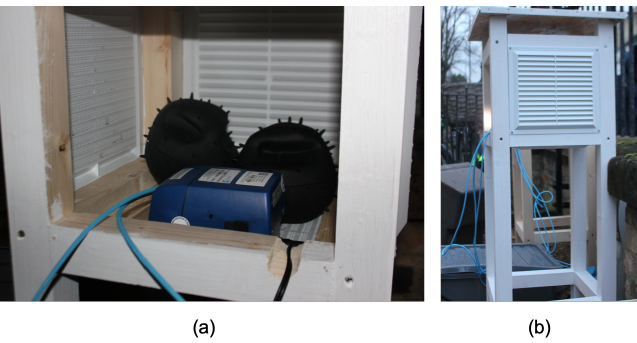
Figure 9. Outdoor colocation setup: ( a ) dustboxes with a TSI AM520; and ( b ) Stevenson screen setup. Table 3. Linear regression parameters and measure of linear correlation (R) between PM2.5 con- centration ( µ g/m 3 ) of TSI AM520 and five Dustboxes at 1 min and 1 h time intervals during out-